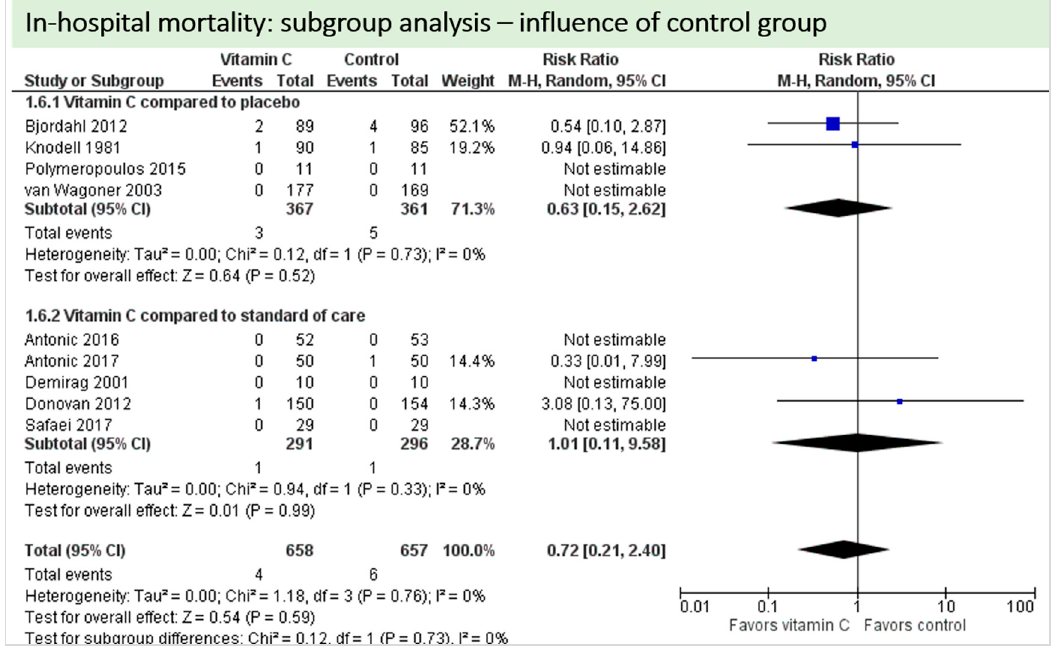
Figure 19. Mortality: subgroup analysis—influence of control group.